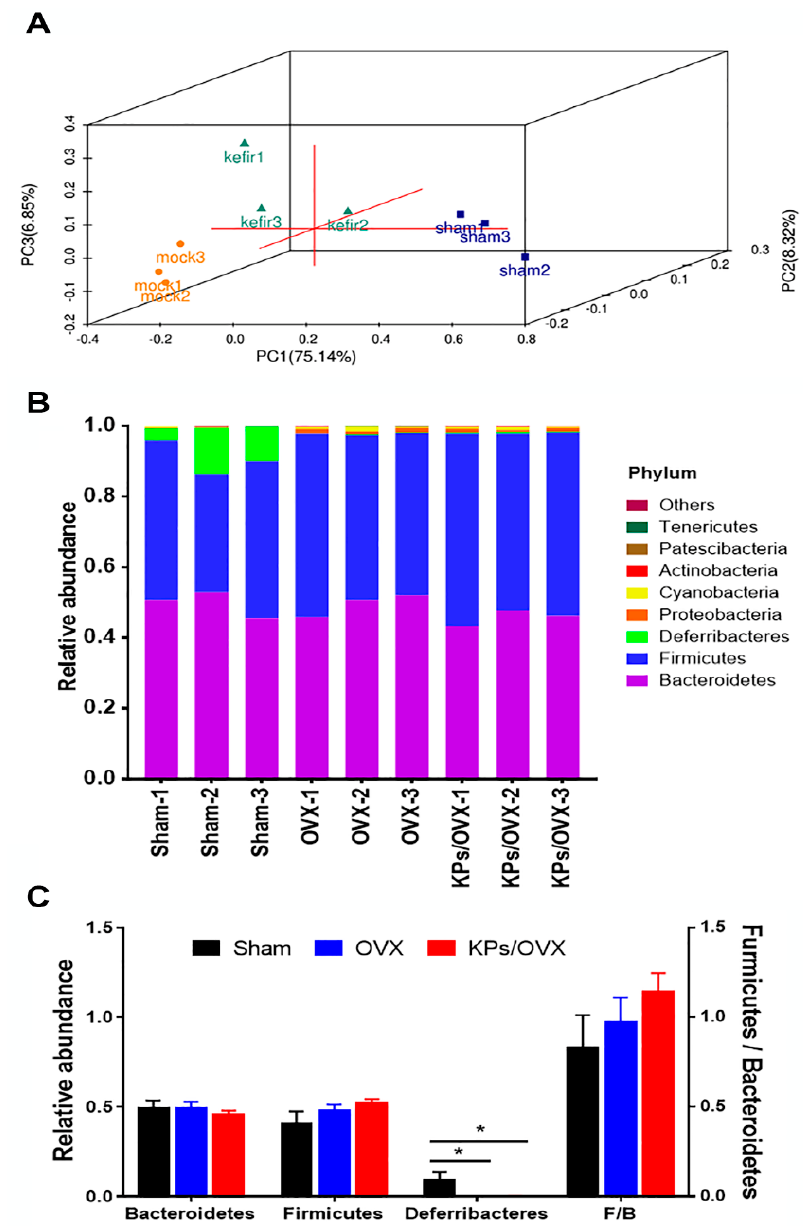
Figure 4. Analysis of the gut microbiota by 16S rDNA amplicon sequencing. ( A ) Principal co-ordinates analysis (PCoA), a common method of β -diversity index analysis, was used to evaluate the differential significance of the total abundance of the gut microbiota among the groups. PC1: Pricipal coordinate analysis axis 1; PC2: Pricipal coordinate analysis axis 2; PC3: Pricipal coordinate analysis axis 3. ( B ) Structural comparison of the gut microbiota at the phylum level. ( C ) Relative abundances of the phyla Bacteroidetes Firmicutes and Deferribacteres, and the ratio of Firmicutes to Bacteroidetes (F/B), a marker of obesity. Statistical analysis was performed by one-way ANOVA and Tukey’s post hoc test. Statistical significances are indicated by asterisks (*, p < 0.05).